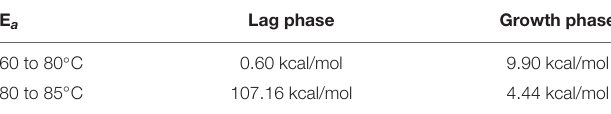
TABLE 6 | Calculation of activation energies into two segments from nonlinear behavior shown by slopes by plotting ln tlag vs. 1000/T and ln( k ) vs. 1000/T. E